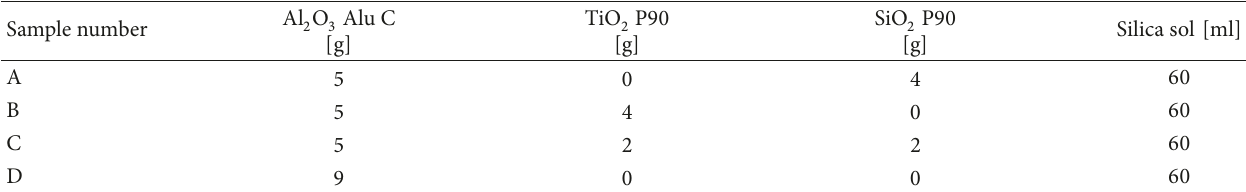
Table 4: Composition of suspensions based mainly on Al 2 O 3 , TiO 2 , and SiO 2 for silica sol-based samples (proportion: 60ml silica sol per 9 g of oxides mixture powder).